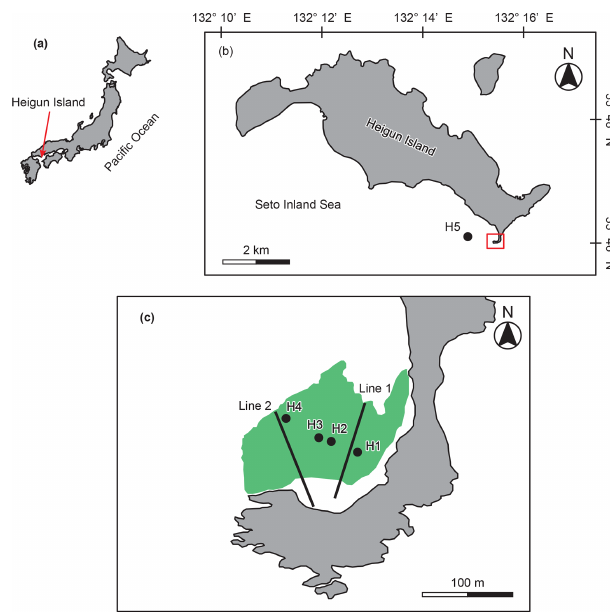
Figure 1. Maps of Heigun Island and the locations of sampling sta- tions (H1–H5) and transect lines. Green shading indicates the area occupied by the macroalgal